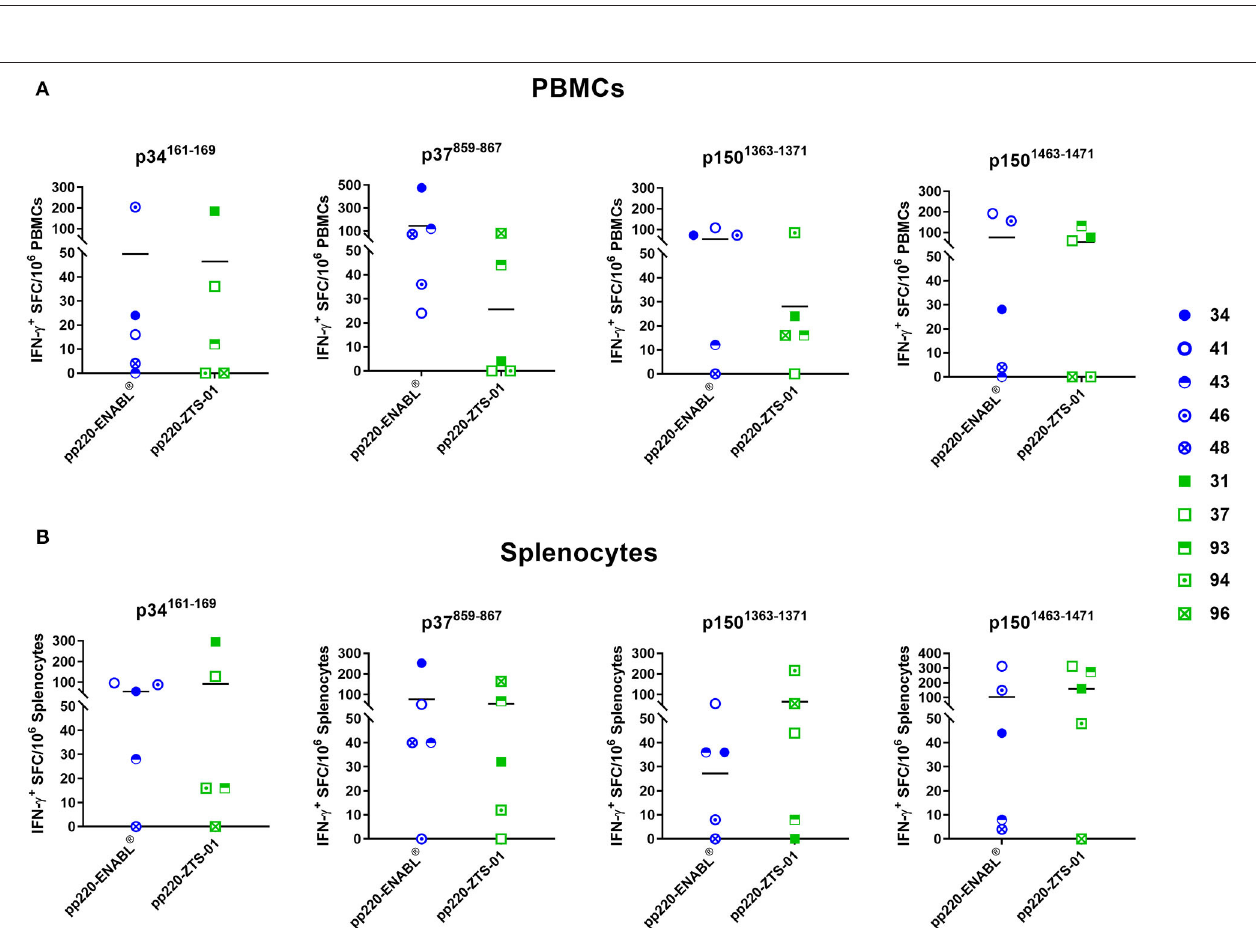
FIGURE 9 | Screening of the predicted pp220 peptide pools. Five pools (Pool A-E) of predicted SLA I -binding peptides from the ASFV (Georgia 2007/1) pp220 polyprotein ( Table 2 ) were used to stimulate (A) PBMCs or (B) splenocytes isolated from pigs immunized with the Ad-pp220-ENABL ® formulation, which were then evaluated for antigen-specific recall IFN- γ responses by EliSpot. Data is presented as Spot Forming Cells (SFC)/10 6 PBMCs or splenocytes for each pig. Medium alone served as the negative control, and the data shown is minus media background counts.